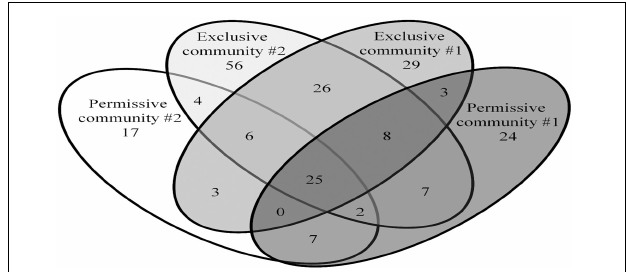
FIGURE 4 | Shared and unique OTUs observed in Salmonella exclusive and permissive cecal communities. Numbers below groups indicate the number of